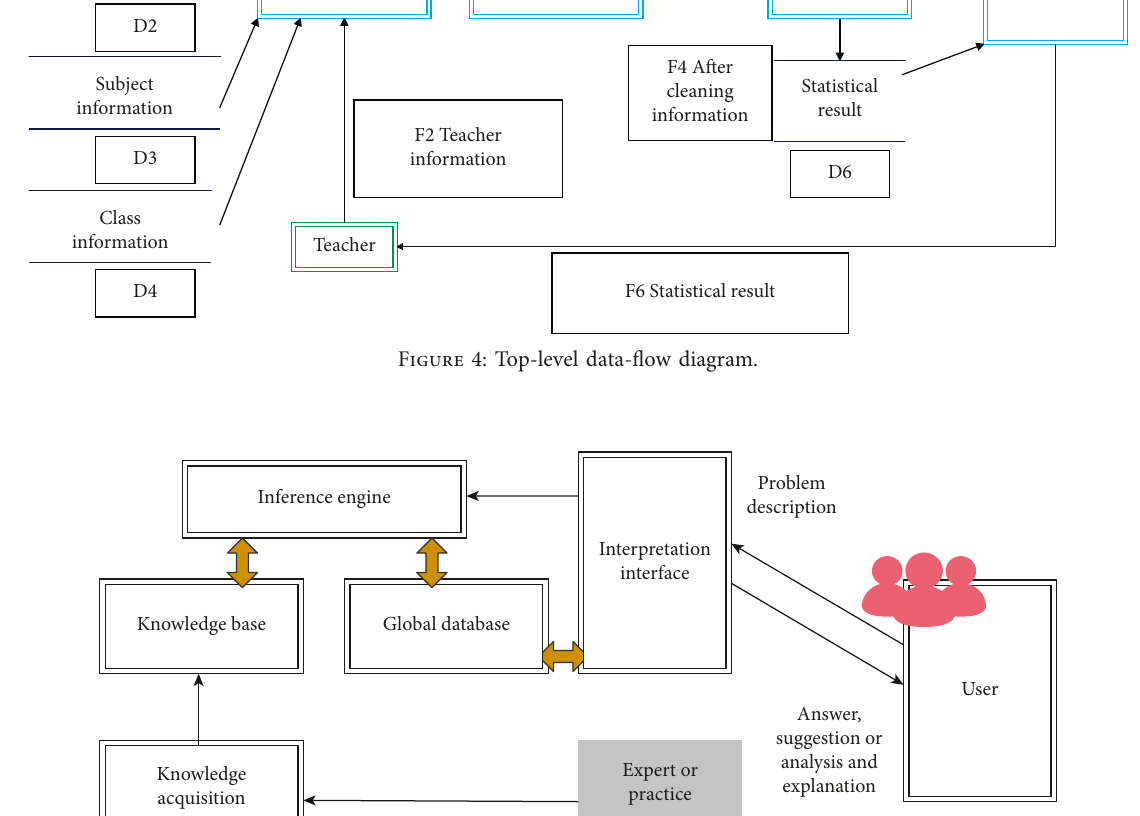
Figure 5: General structure of the international Chinese education expert